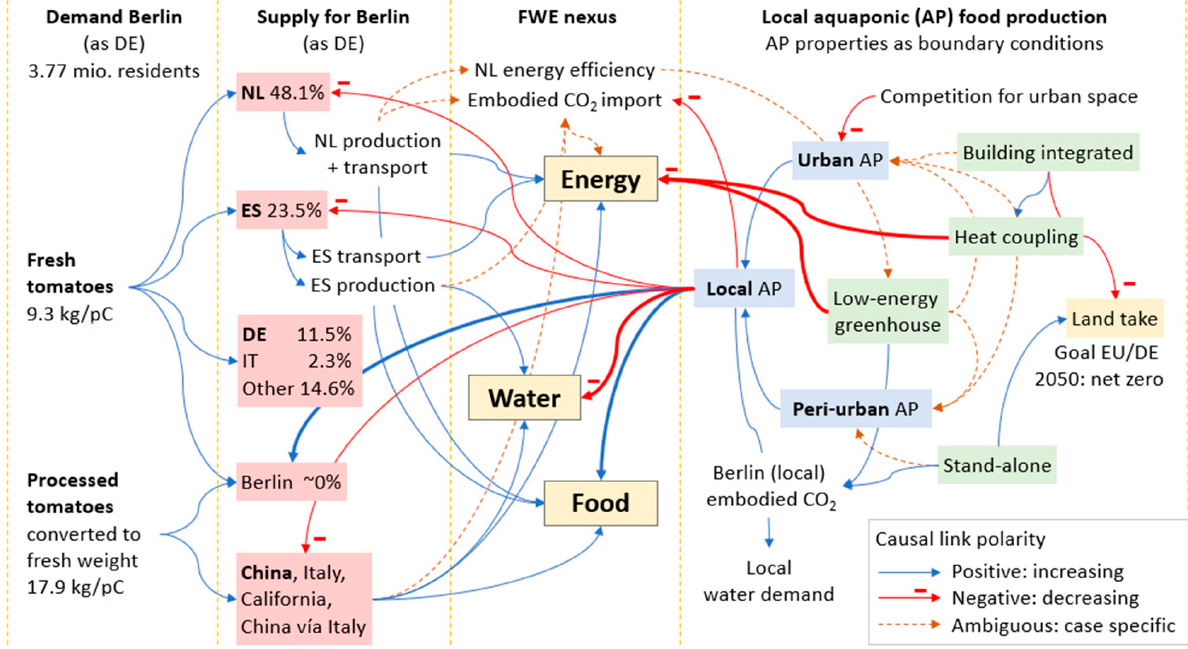
Figure 4. Impact of simplified causal relations on the FWE nexus concerning year-round tomato production and aquaponic setup as boundary conditions for production-location shift; FWE ranking was conducted according to the main dependencies of the sectors; swim lanes are explained in Table 6.